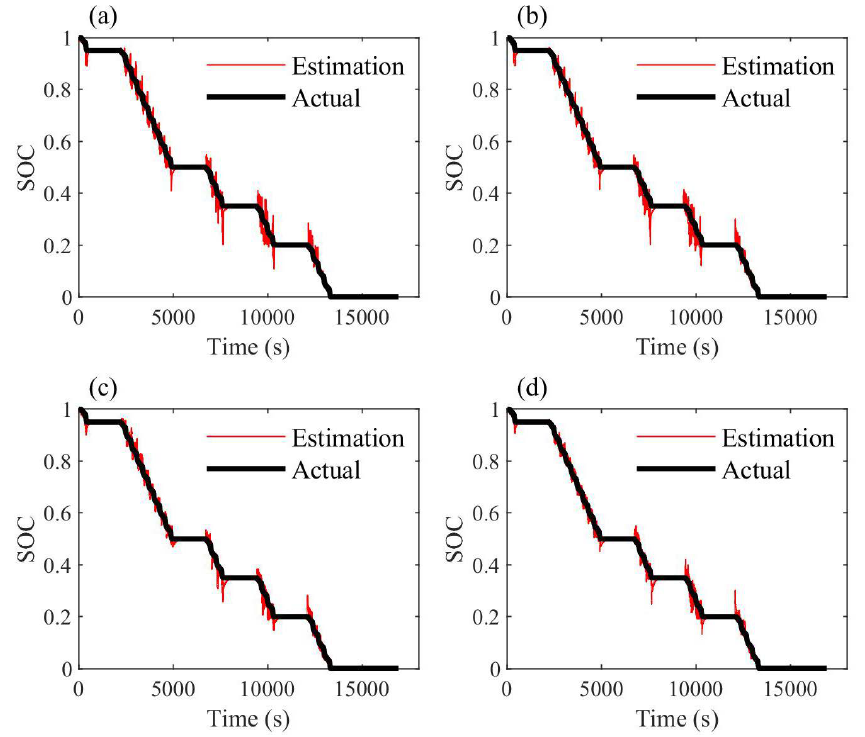
Figure 9. SOC estimation results for the DST profile in the four modes: ( a ) first mode, ( b ) second mode, ( c ) third mode, and ( d ) fourth